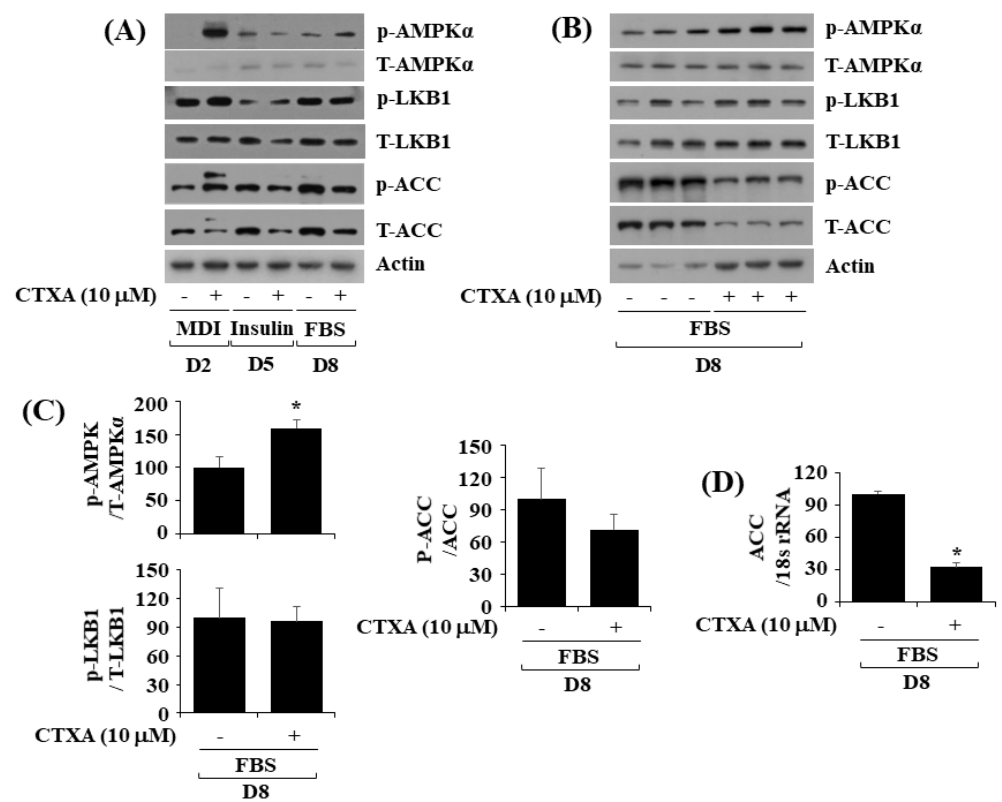
Figure 4. Effects of CTXA on expression and phosphorylation level of cAMP-activated protein kinase (AMPK) α , liver kinase B1 (LKB1), and acetyl-CoA carboxylase (ACC) during 3T3-L1 preadipocyte differentiation. ( A ) 3T3-L1 preadipocytes were differentiated with induction medium containing MDI, insulin, and FBS in the absence (control; 0.1 % DMSO) or presence of CTXA (10 µ M), and harvested at day 2 (D2), D5, and D8, respectively. At each time point, whole cell lysates were prepared and analyzed by immunoblot analysis with respective antibodies. p -AMPK α , phosphorylated AMPK α ; T- AMPK α , total AMPK α ; p -LKB1, phosphorylated LKB1; T-LKB1, total LKB1; p -ACC, phosphorylated ACC; T-ACC, total ACC. ( B ) Western blot analysis in triplicate experiments on D8. ( C ) Densitometry analysis of ( B ). * p < 0.05 compared to vehicle control. ( D ) Total cellular RNA was extracted at D8 and analyzed by real-time qPCR with respective primers. Data are mean ± SE of three independent experiments. * p < 0.05 vs.